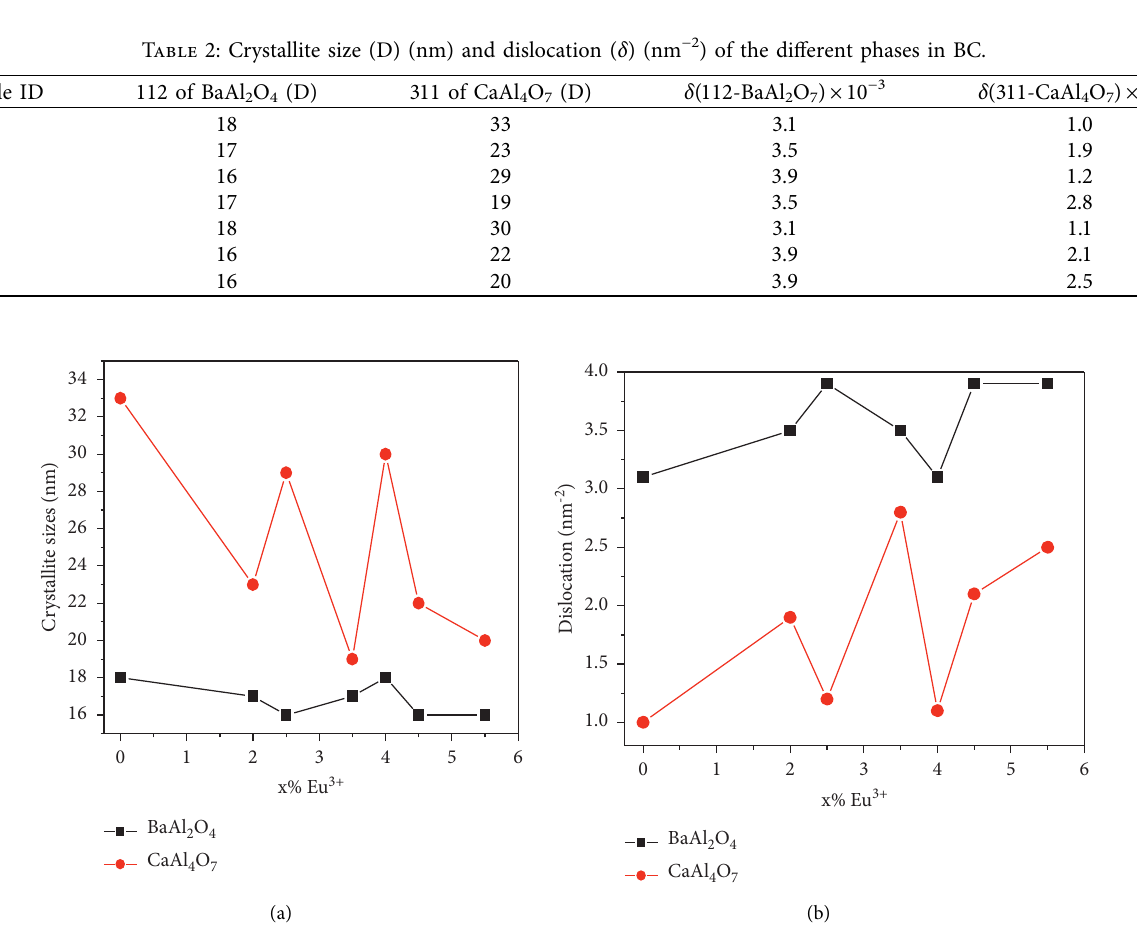
Figure 4: (a) Crystallite sizes versus x % Eu 3+ and (b) dislocation versus x % Eu 3+ .